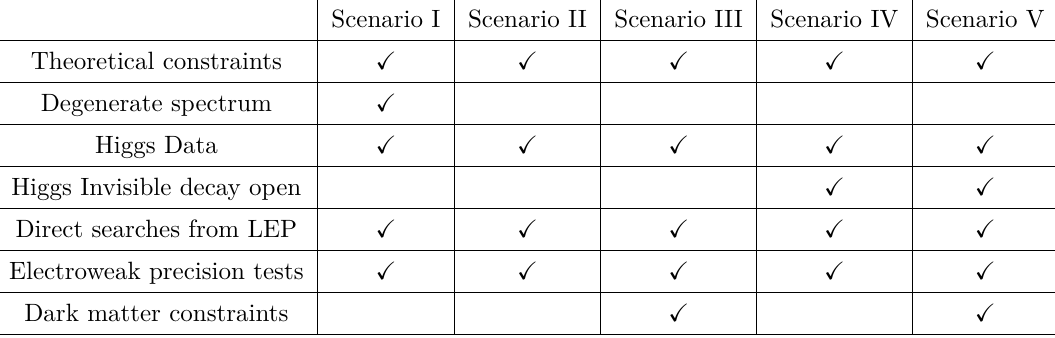
Table 2 . Scenarios and their conditions are